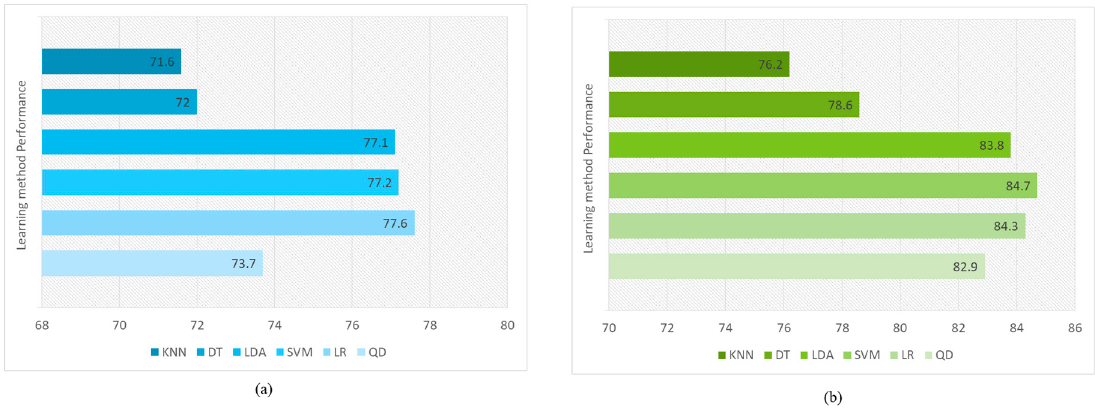
Figure 19. The accuracy of learning classifiers on diabetes dataset is shown in the graphs ( a ) Learning algorithm results before enhancing the data ( b ) Improved results after enhancing the data with data processing methods.